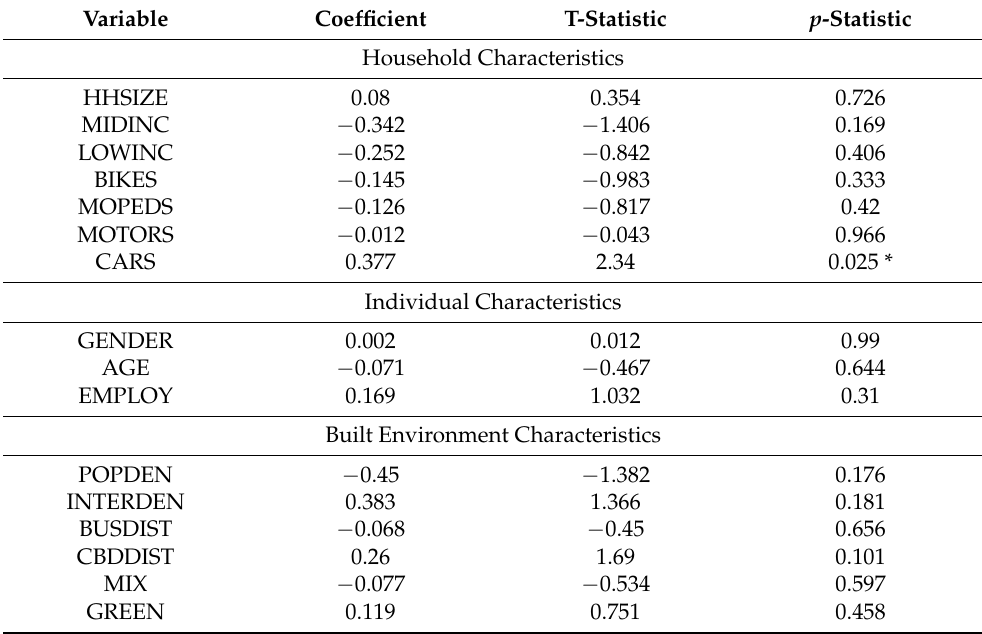
Table 6. The details of multilinear